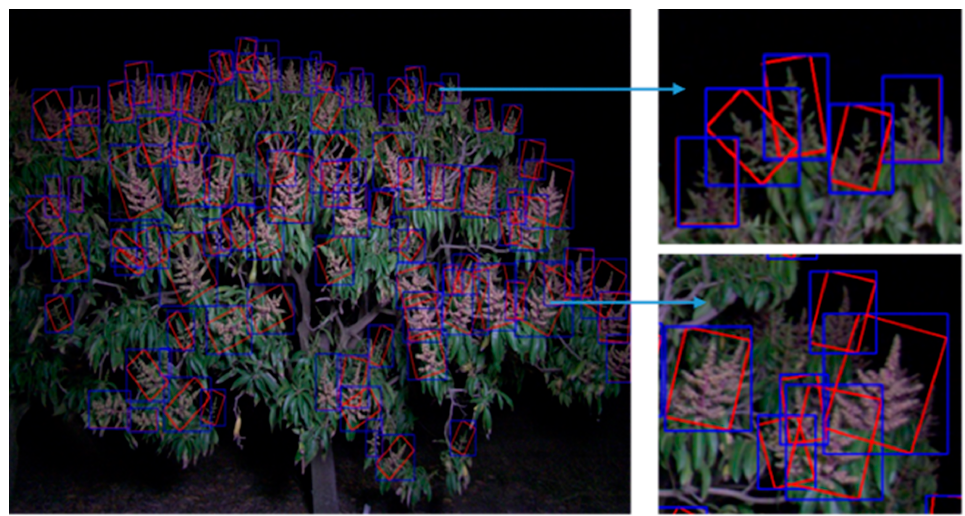
Figure 3. Visualization of ground truth bounding box original (rotated) red colour for R 2 CNN training and transformed (upright) blue colour for MangoYOLO training.